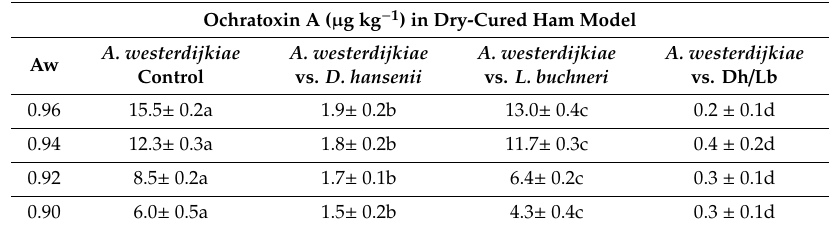
Table 6. Mean production of Ochratoxin A by A. westerdijkiae in control and selected D. hansenii and